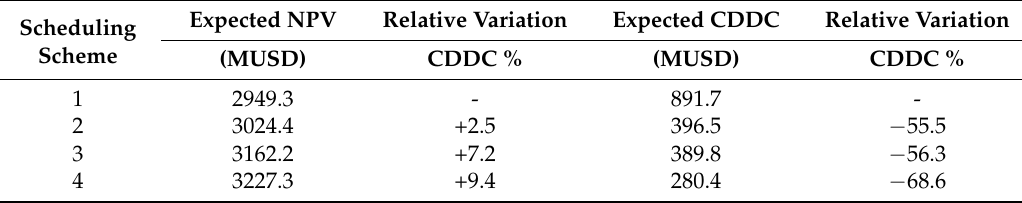
Table 7. Summary of main economic results of the case